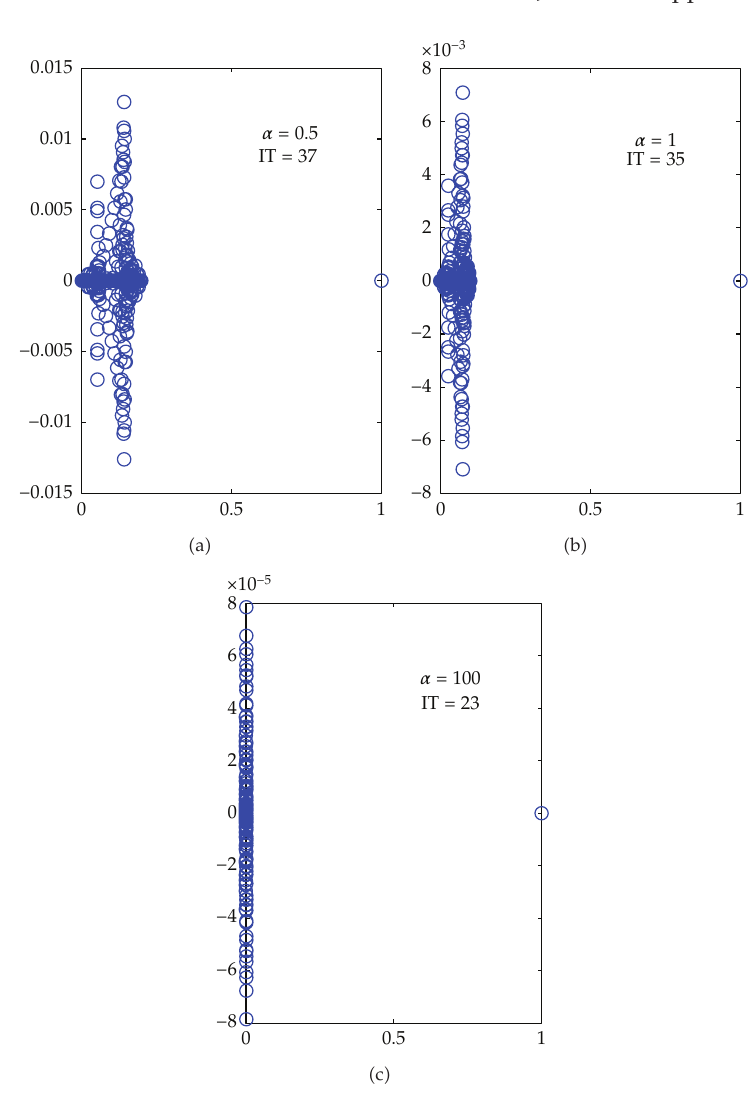
Figure 2: Spectrum of preconditioned generalized steady Oseen matrix, 32 × 32 grid with υ (cid:6) 0 . 001.